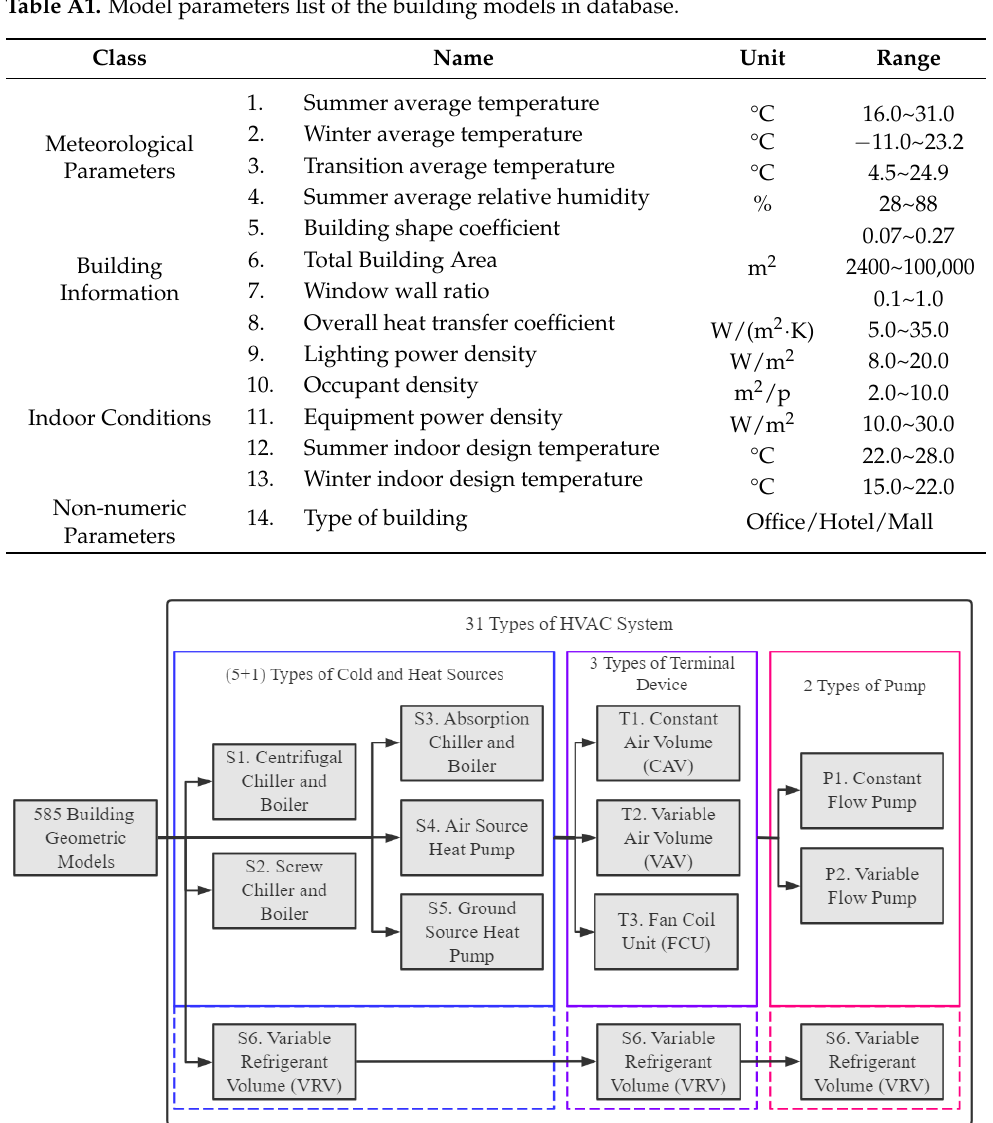
Figure A1. Various possible subsystems of the total HVAC system in the model database.